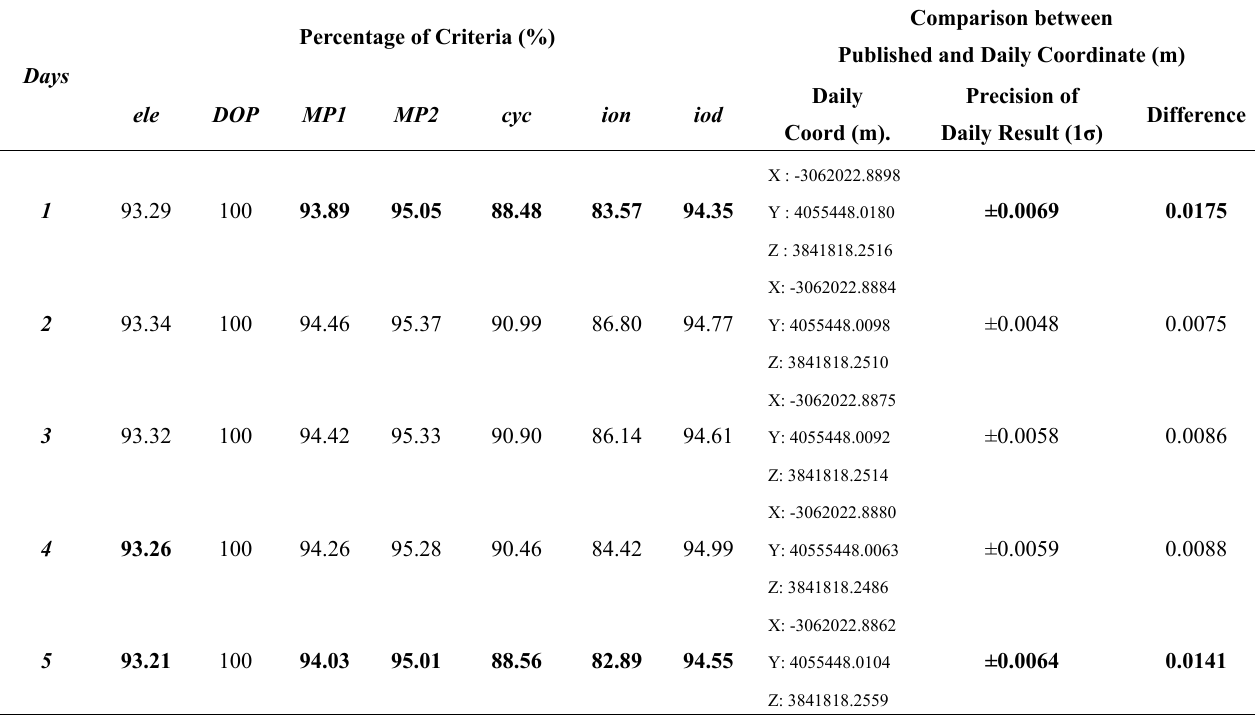
Table 3. Comparison of indicators and precision of